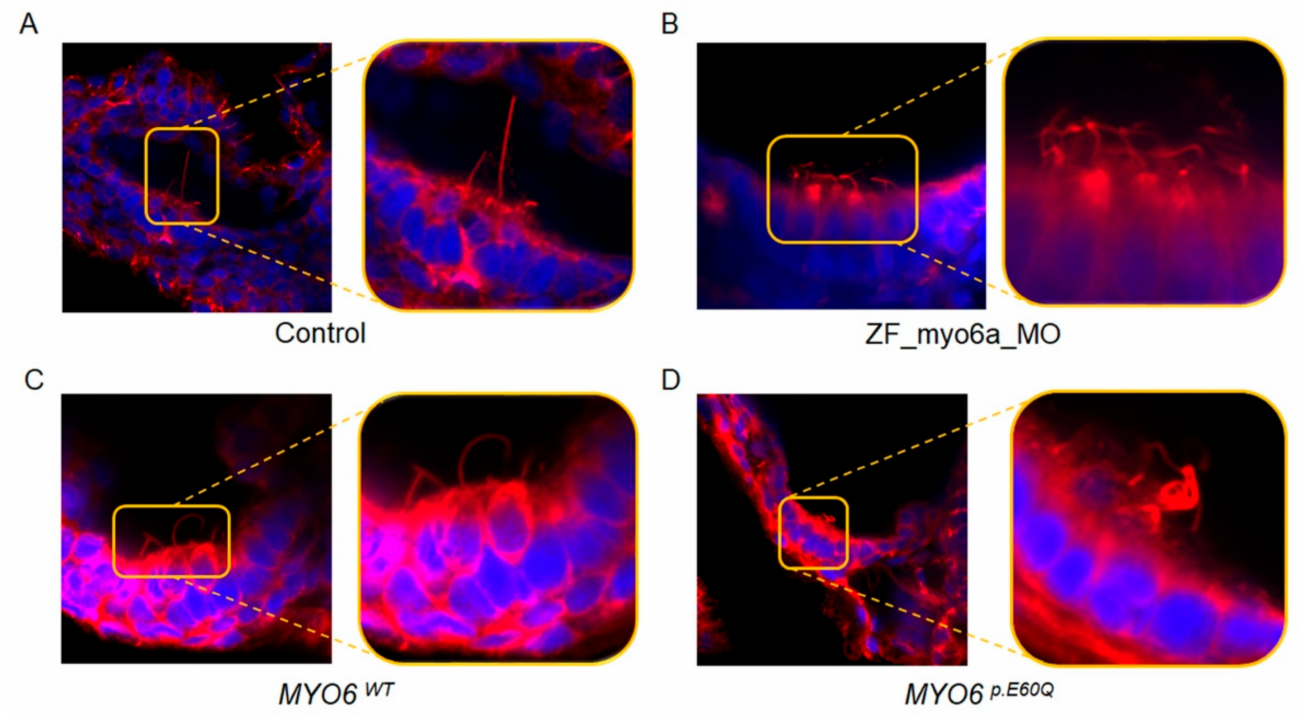
Figure 5. Inner ear hair cell characterization. Representative image of inner ear hair bundle phenotype of zebrafish larvae at 72 hpf of ( A ) Control, ( B ) ZF_myo6a_MO total knock-out, and the rescue with ( C ) wild type MYO6 p.E60Q and ( D ) MYO6 p.E60Q mutation. Representative image of inner ear hair bundle phenotype of zebrafish larvae at 72 hpf. F-actin-rich hair bundles were visualized using fluorescent acetylated tubulin and visualized using Airyscan confocal microscopy at a magnification of 100 ×